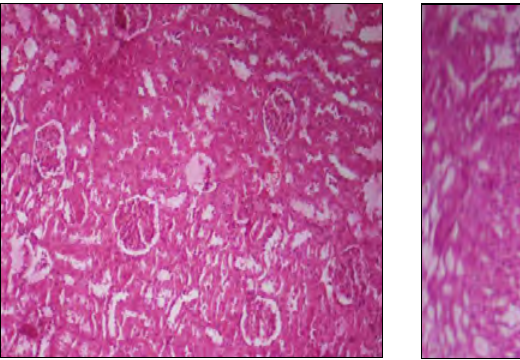
Figure-5. Photomicrograph of kidney showing mild degenerative changes. H&E X200 (Group 7)